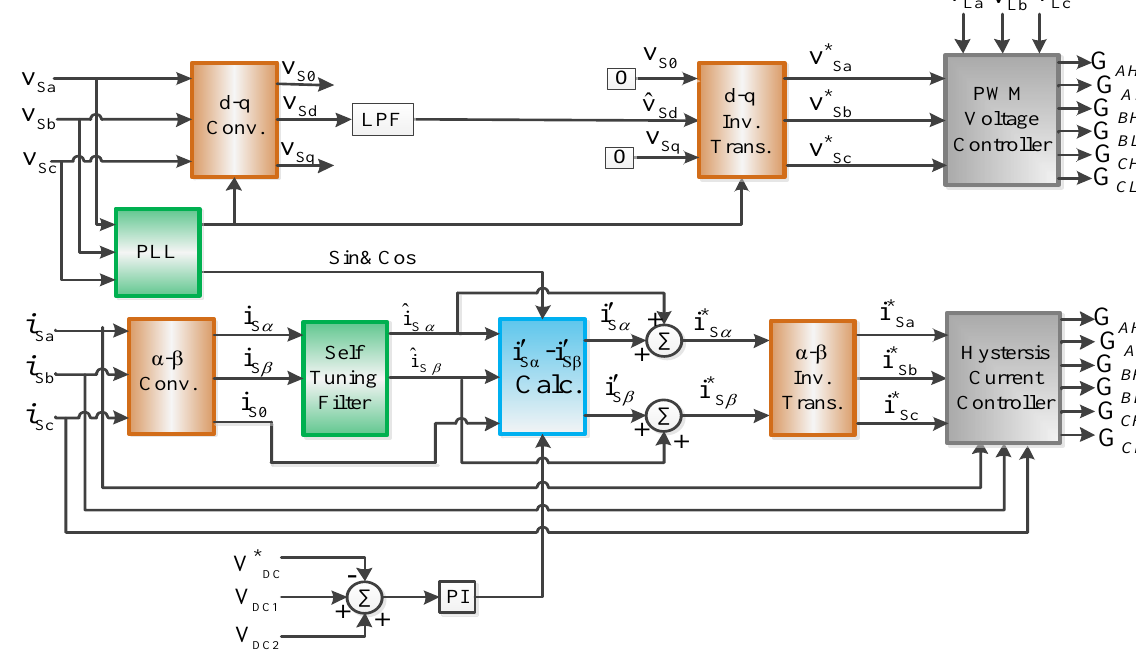
Figure 4. The block diagram of proposed control method for